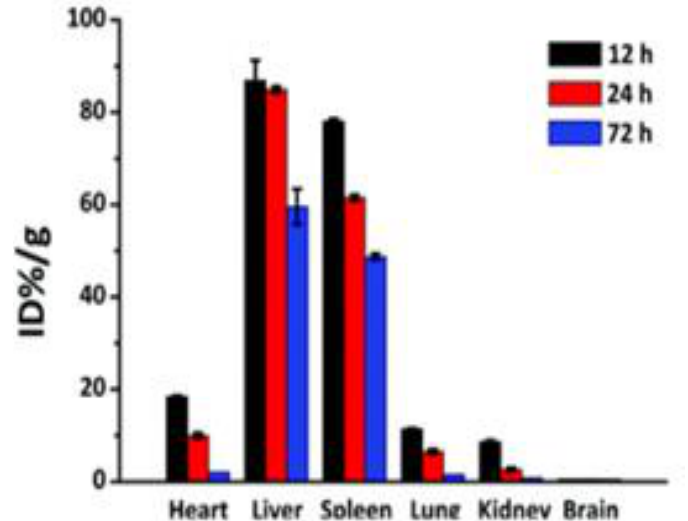
Figure 3: The concentration of AuSiNShs in major organs after 12, 24, and 72 hr periods post-injection